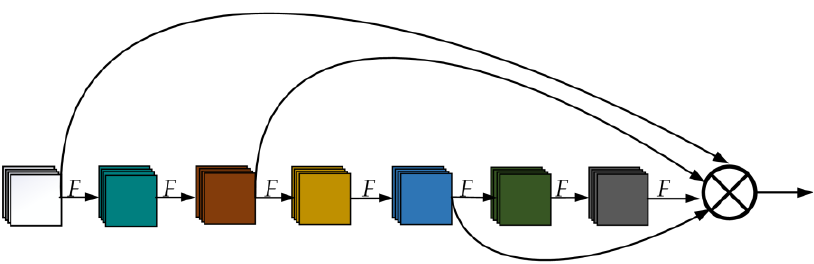
Figure 1. Schematic representation of the structure of the Res3Uint module, where F represents the convolution layer and ⊗ indicates concatenation.